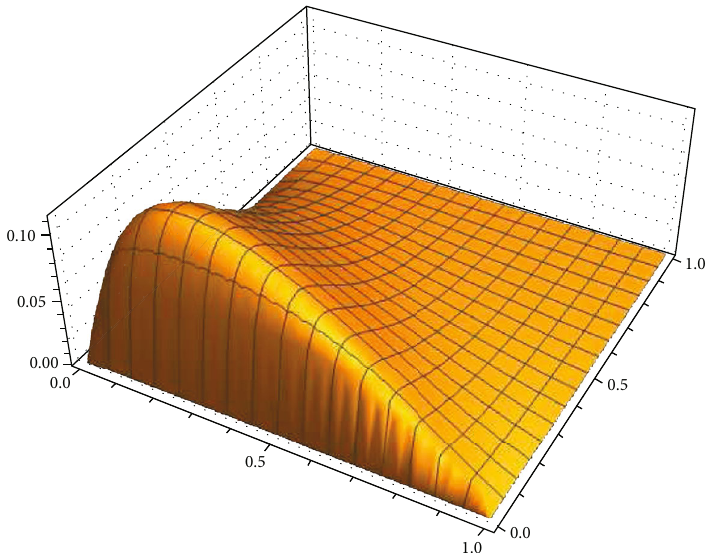
= 1 and v = 1 in the uv -plane 1 , which is zero along the lines u